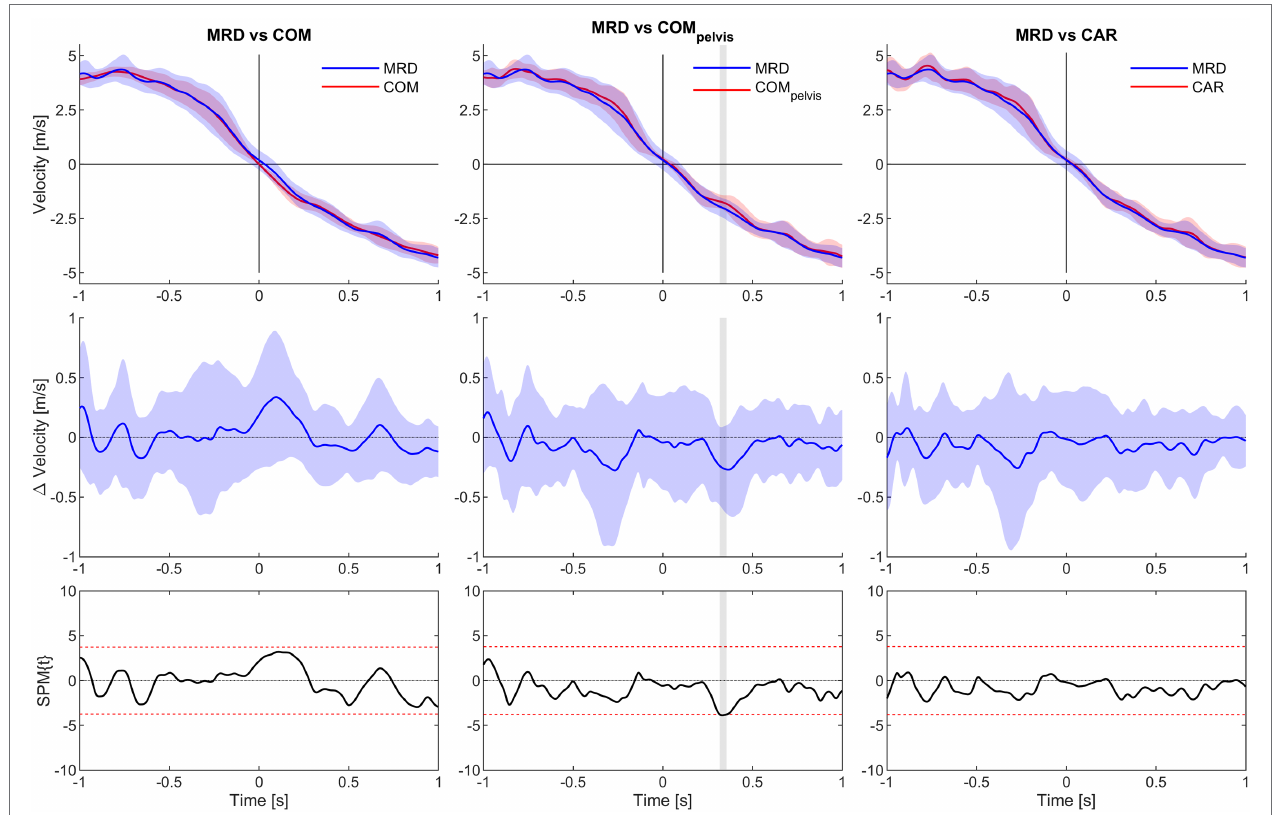
FIGURE 5 | SPM analysis of average velocity for 1.0 s time interval before ( − ) and after (+) CoD (horizontal axis all graphs) for the 3 kg condition. Columns left to right show MRD to COM, MRD to COM pelvis and MRD to CAR comparisons. Top row show average velocity of all trials with 95% confidence interval for the MRD (blue) to COM, COM pelvis and CAR (red) comparisons. Middle row show difference in velocity with 95% confidence interval. Bottom row show SPM analysis with 95% confidence interval marked with red dashed lines. Grey vertical line identify time interval of significant difference ( α <